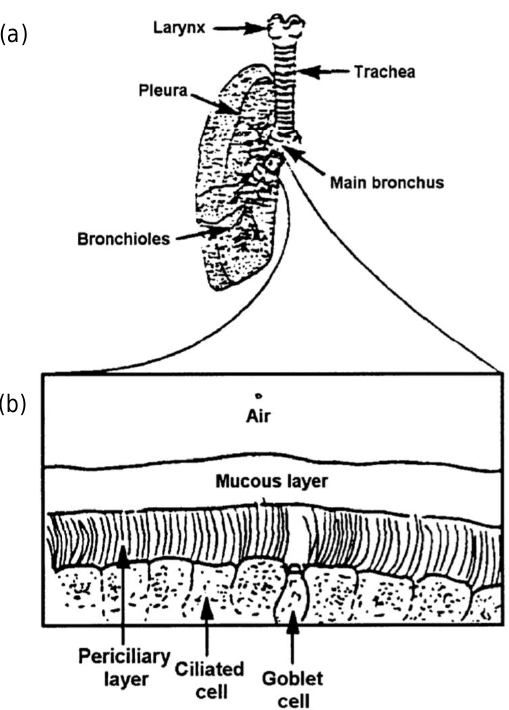
Figure 1. Schematic plots of the mucociliary system in the lung: ( a ) a human lung structure, ( b ) enlargement near the lung surface, from Blake [14] with permission.